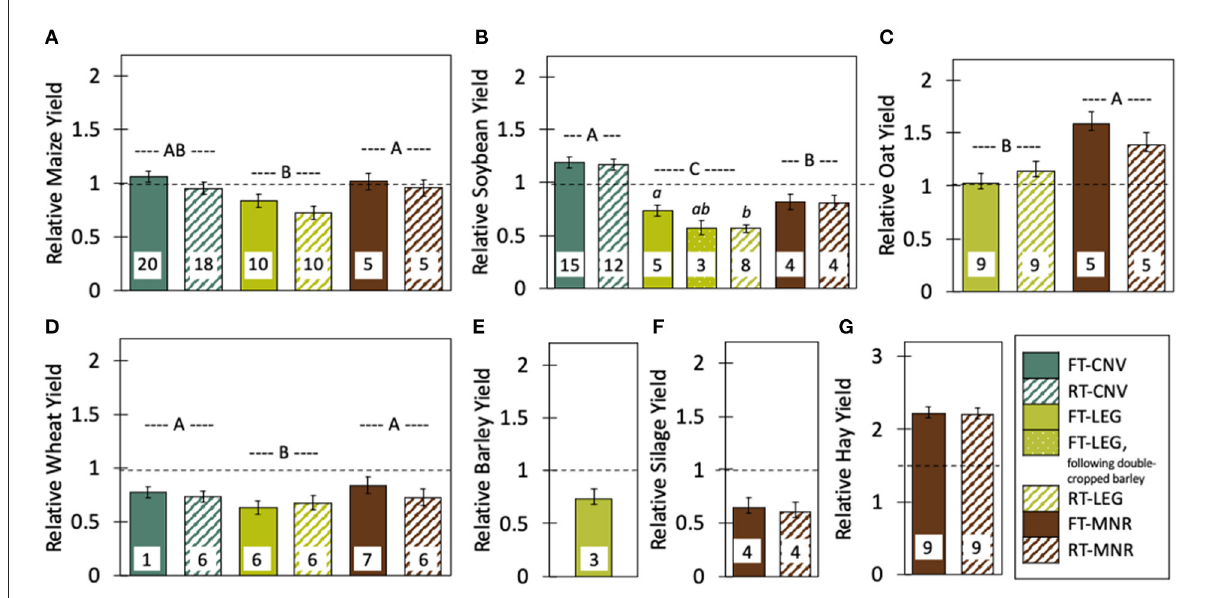
FIGURE1 Relative yields across all tillage × system treatments in the FST from 2008–2020 for (A) maize [System: χ 2 2 = 31.8, P < 0.0001, Tillage (System): χ 2 3 = 4.7, P = 0.20], (B) soybeans [System: χ 2 2 = 279.2, P < 0.0001, Tillage (System): χ 2 3 = 4.9, P = 0.18], (C) oats [System: χ 2 2 = 29.3, P < 0.0001, Tillage (System): χ 2 3 = 6.2, P = 0.05], (D) wheat [System: χ 2 2 = 18.5, P < 0.0001, Tillage (System): χ 2 3 = 11.2, P = 0.01], (E) barley, (F) maize silage (Tillage: χ 2 3 = 0.7, P = 0.42), and (G) hay (Tillage: χ 2 3 = 0.02, P = 0.90). Means and error bars are estimated marginal means (EMM) and standard errors from mixed models. Different uppercase letters above bars indicate significant differences across systems (Tukey HSD, P < 0.05). Different lowercase letters above bars in (B) indicate significant differences in soybean yields across tillage treatments, with FT yields split between soybeans that were planted following rye cover crops (solid green bar) or double-cropped following barley (green bar with white dots).